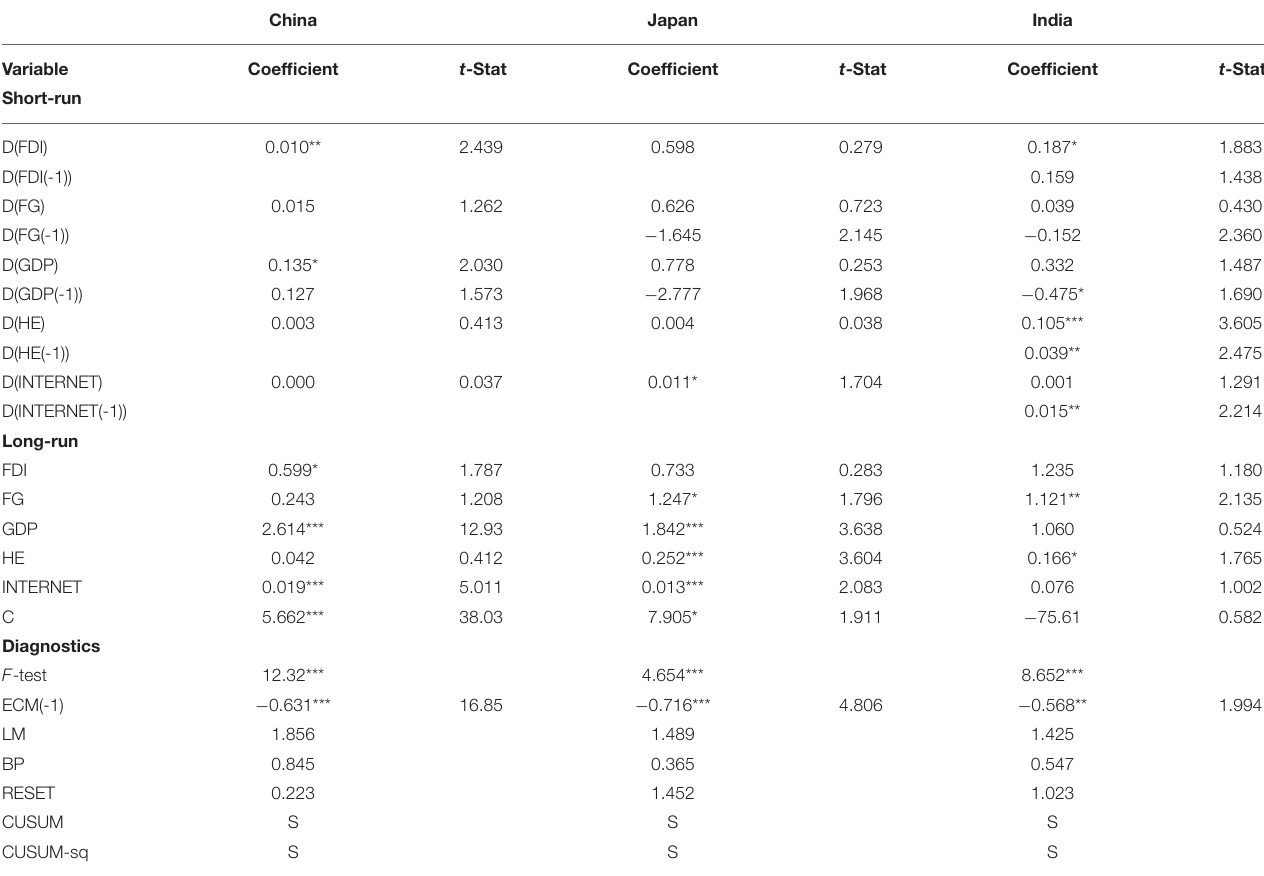
TABLE 3 | Short and long-run estimates of